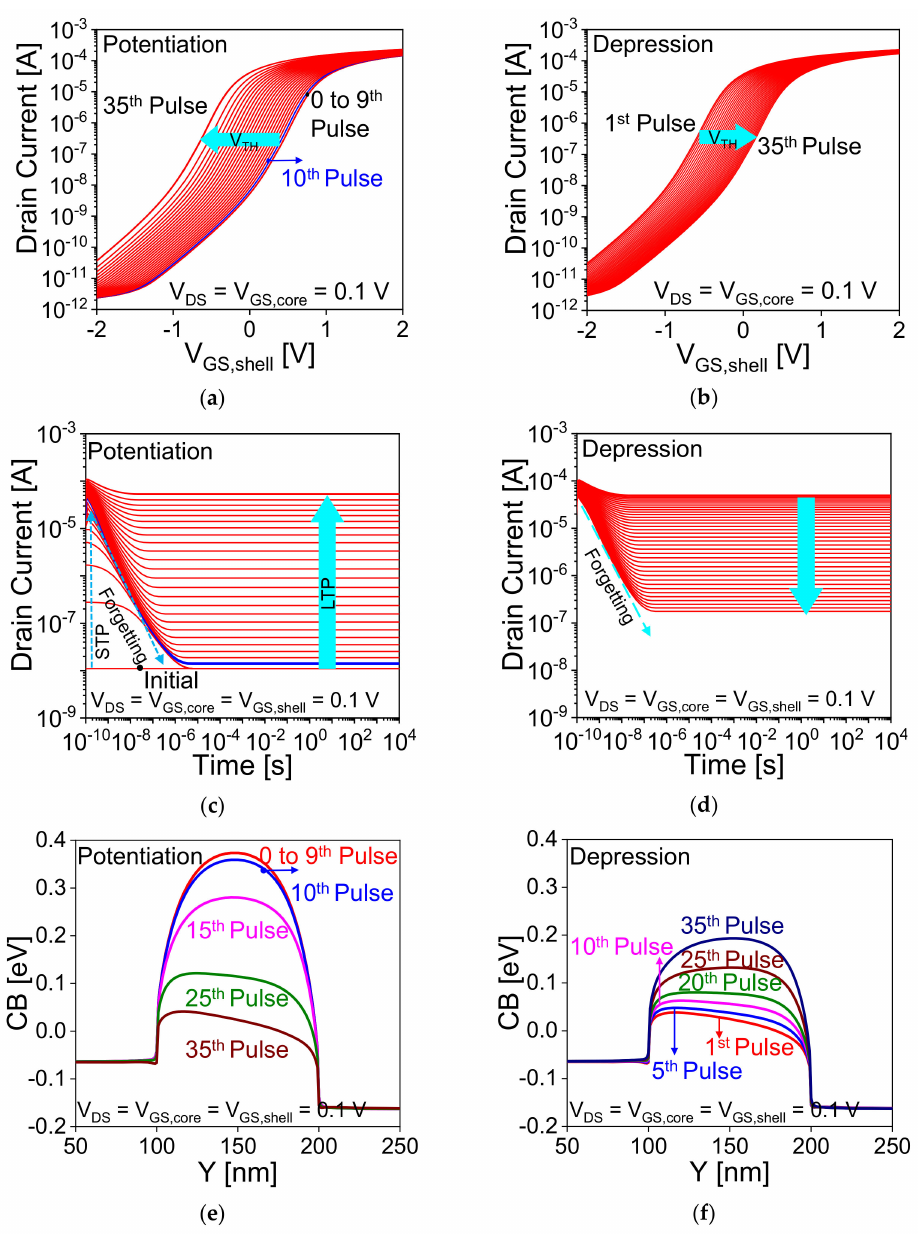
Figure 8. Transfer characteristics of the device during inference (read) operation for ( a ) potentiation ( b ) depression at different pulses. Transient analysis during read operation for ( c ) potentiation ( d ) depression at different pulses. Variation in conduction band (CB) during inference operation for different ( e ) potentiation and ( f ) depression